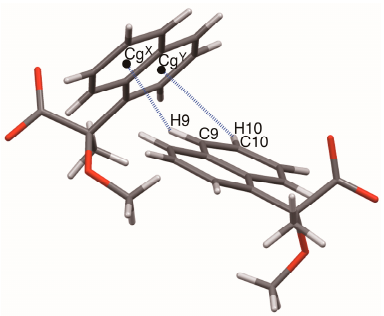
Figure 12. Geometrical parameters of the homo-aromatic C–H ∙∙∙π interactions between the naphthyl groups in salts 6 – 9 . Centroids of benzene rings: Cg X , C9–C14; Cg Y , C5–C6–C7–C8–C14–C–13.